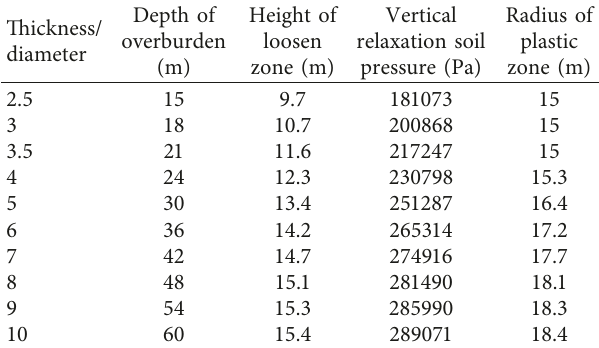
Figure 7: Variation of segment displacement and vertical pressure at different layers. Table 2: Theoretical calculation results at different working